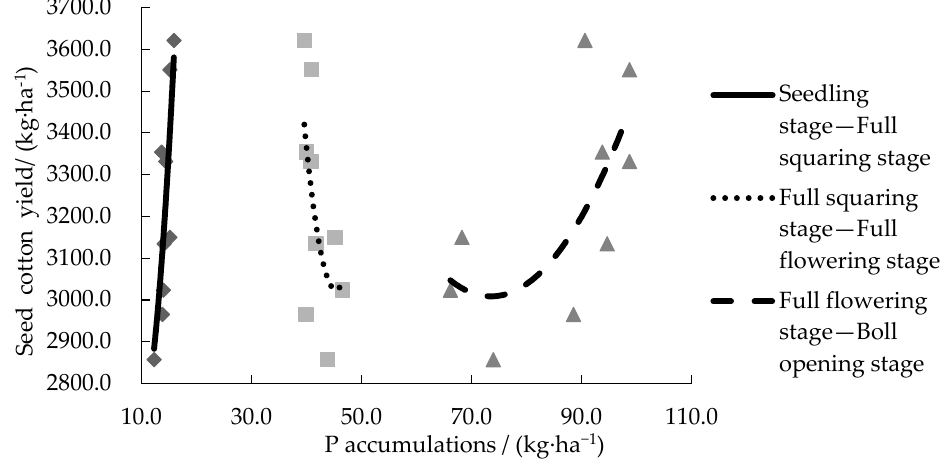
Figure 3. Relationship between seed cotton yield and P accumulations at different growth stages.